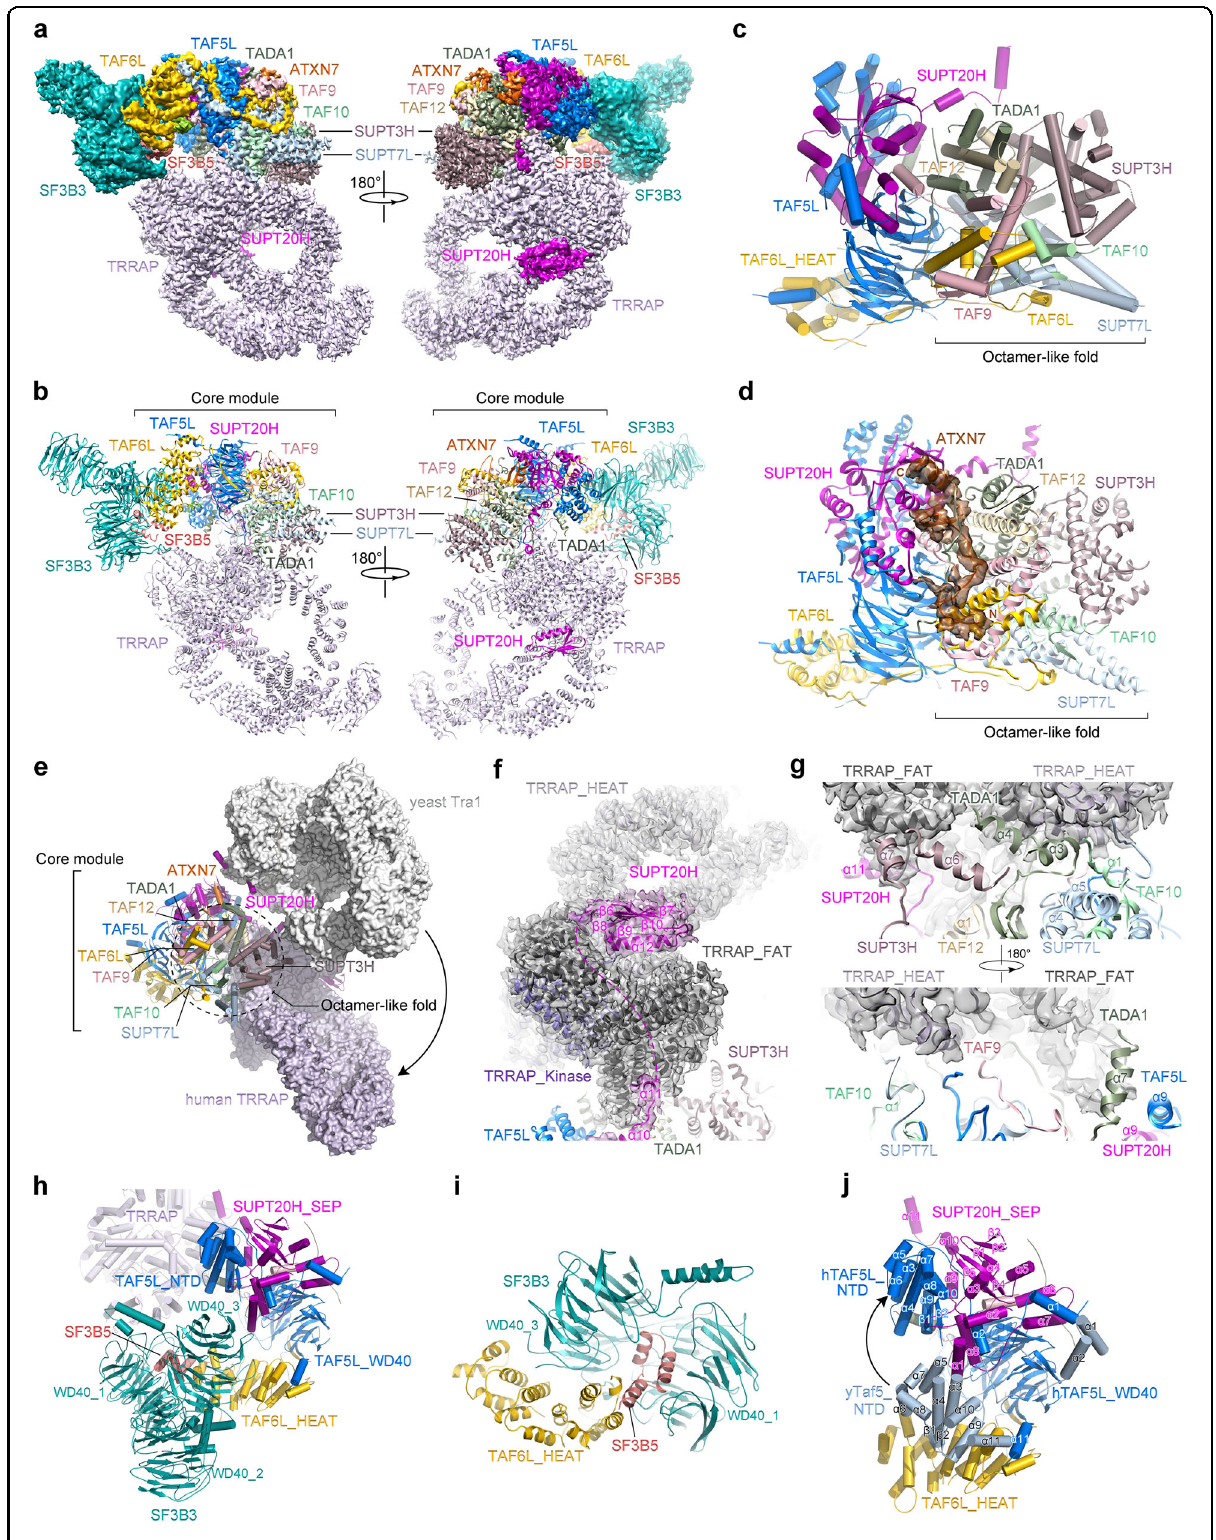
Fig. 1 (See legend on next